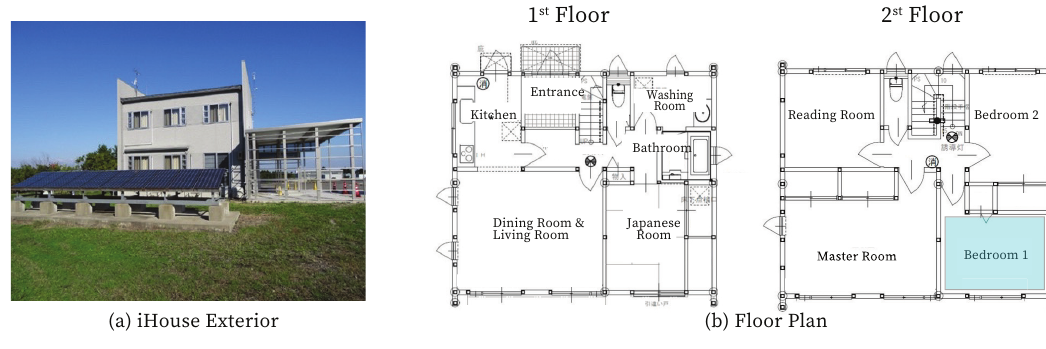
Figure 2. iHouse exterior and architectural plan. Table 4. Brief information on main sensors and wearable